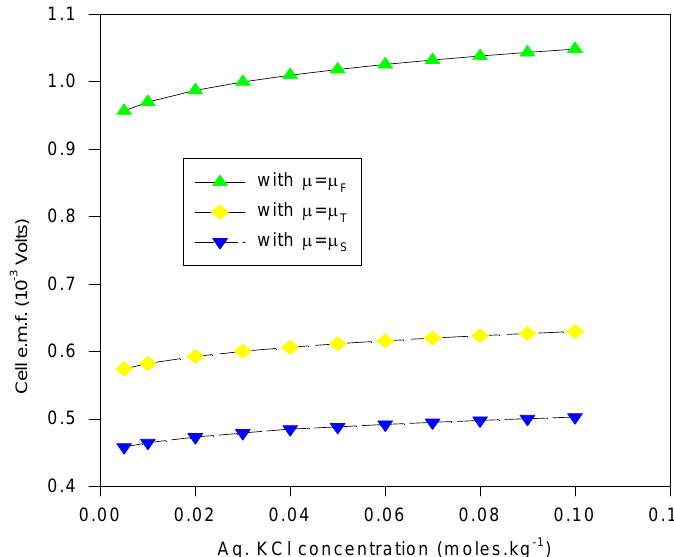
Figure 11. Cell e.m.f. for various µ, based on solution of dielectric equation for KCl concentration in AgCl dielectric.